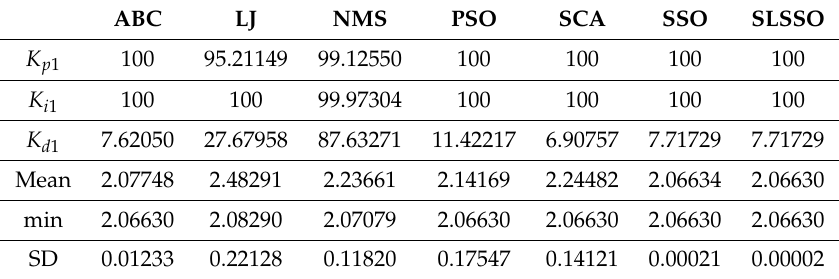
Table 4. Values of controller parameters for control loop I.